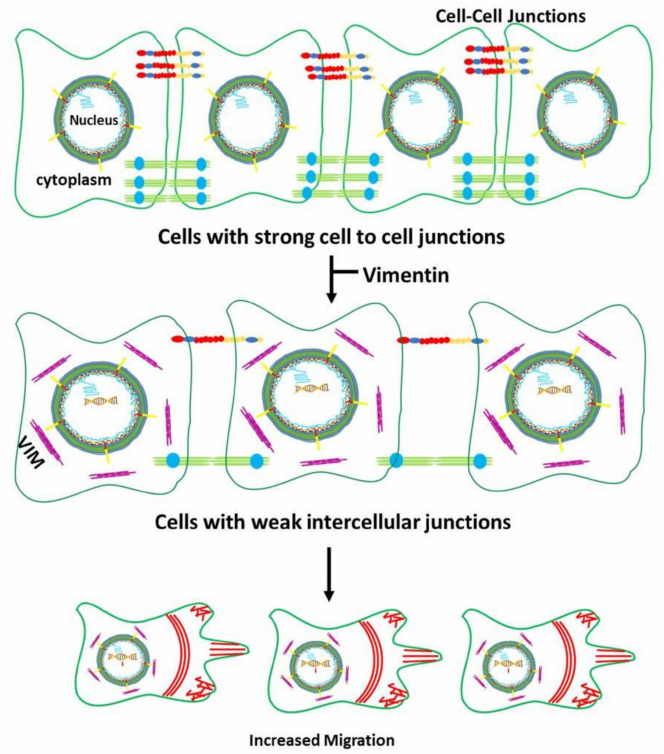
Figure 8. A model for vimentin-induced augmentation of cell migration: Expression of vimentin in breast cancer cells perturbs expression of lamins A, B1 and B2 which is predicted to have a subtle influence on the nuclear architecture as lamins are known to stabilize the nuclear lamina. This leads to changes in gene transcription, especially downregulation of those encoding cell–cell junction proteins (depicted in red/yellow/blue and green/blue lines). Consequently, this reduces intercellular associations and makes the cancer cells less adherent to each other, thus enhancing